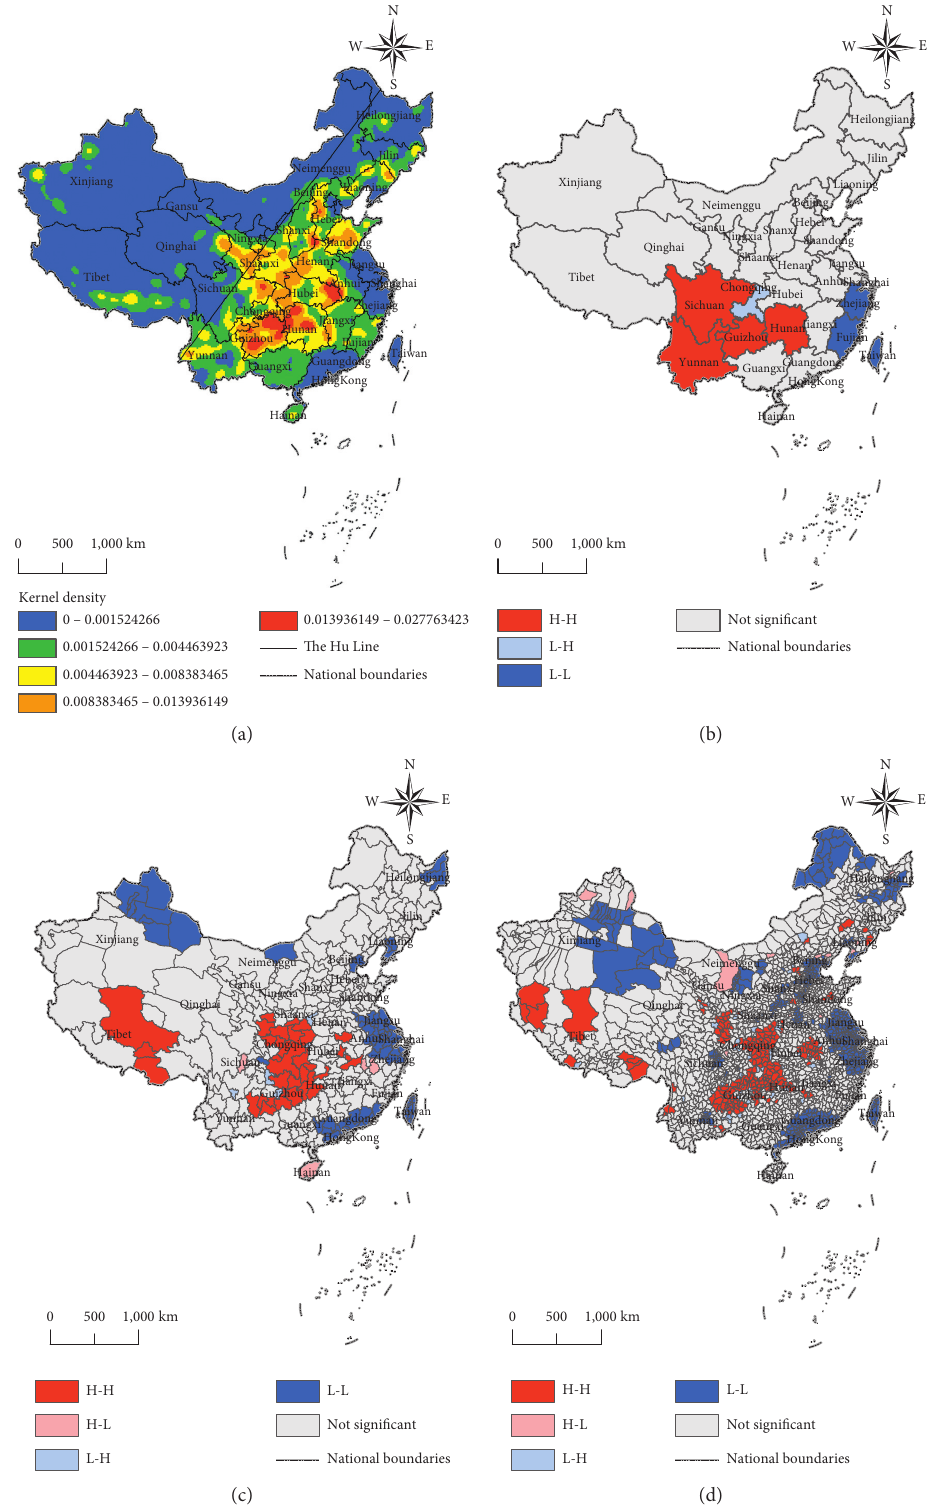
Figure 2: The spatial distribution characteristics map of pro-poor tourism villages in